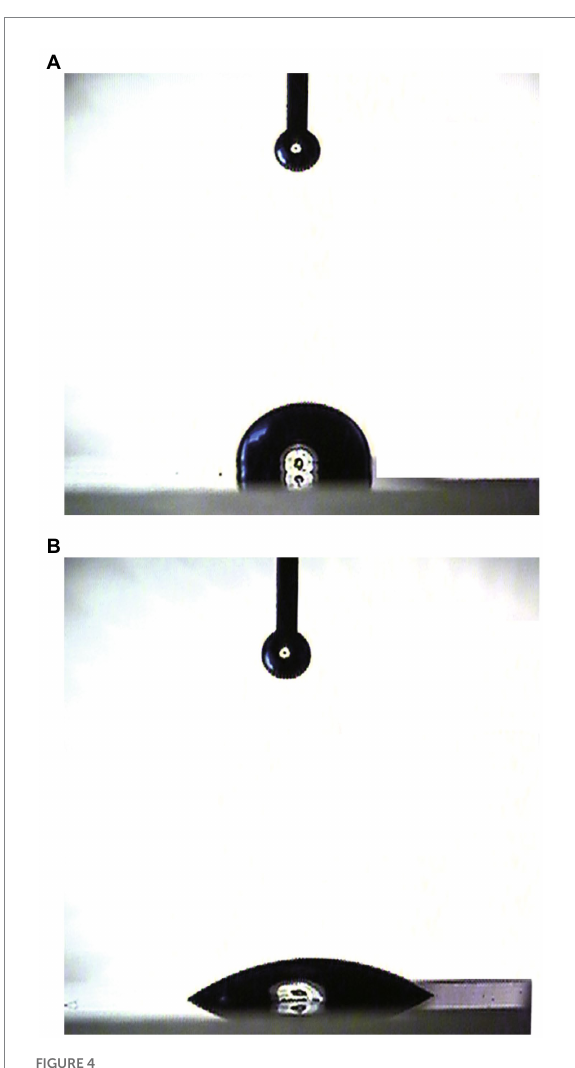
FIGURE 4 Water contact angle measurement of the surface modification ability of HGFII. (A) Uncoated siliconized glass. (B) HGFII-coated siliconized glass.